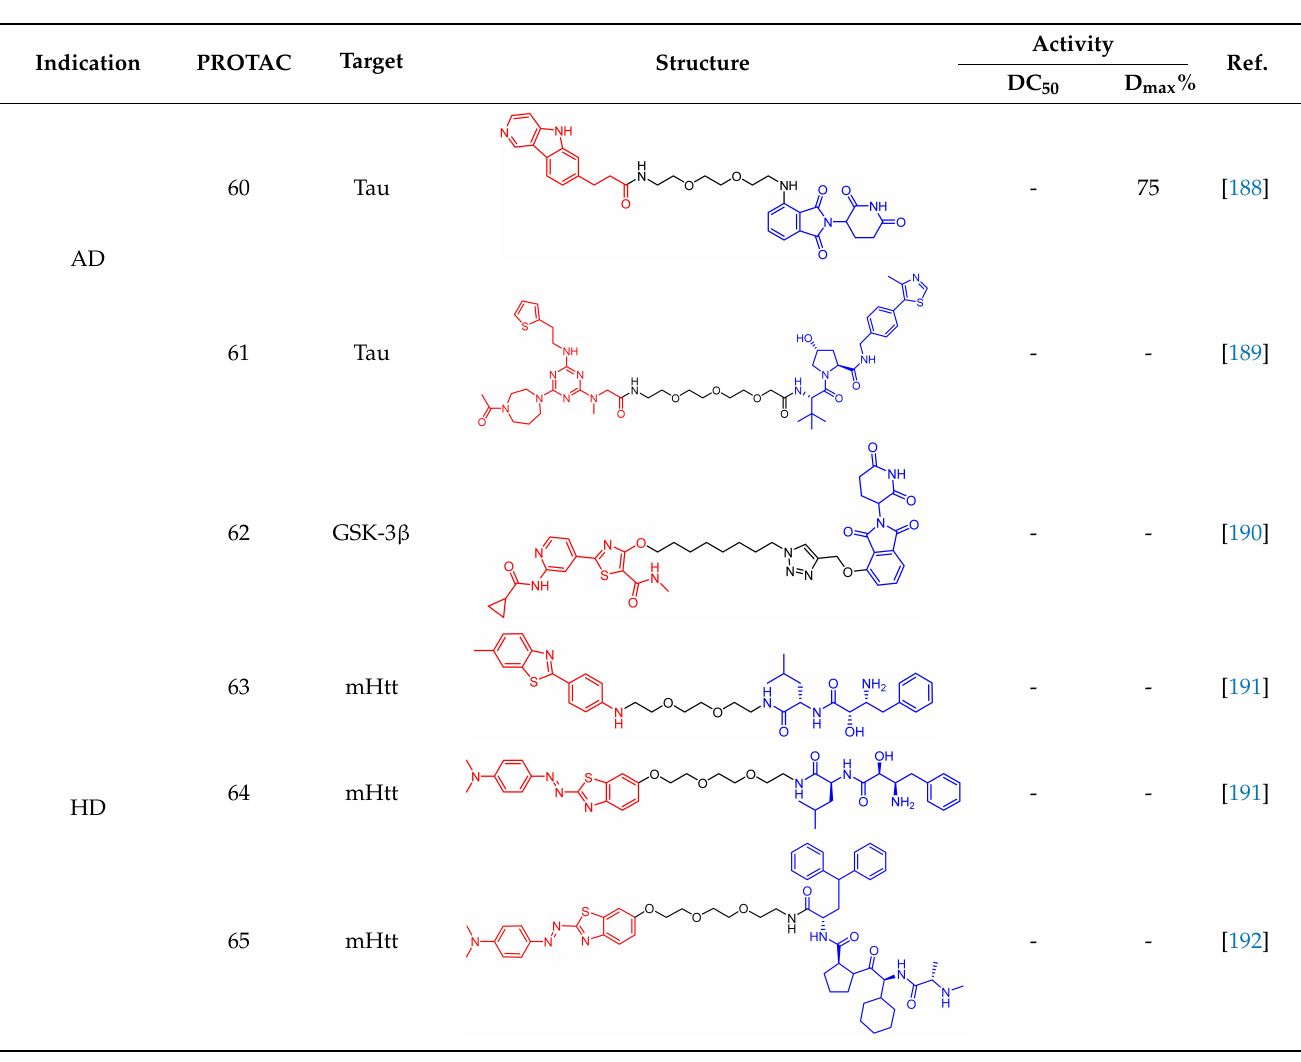
Table 3. Representative PROTACs for neurodegenerative